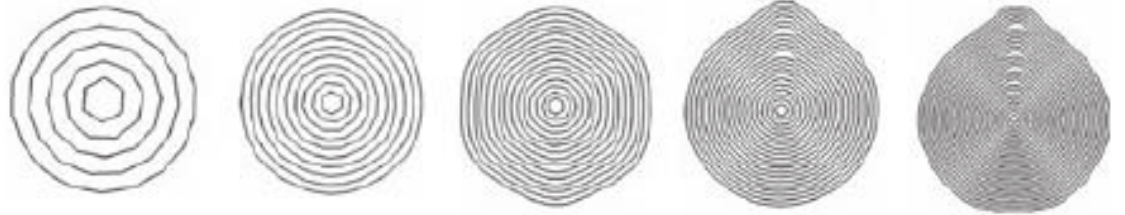
Figure 8. Cross-sectional views of relaxed MWNTs indexed by (2,8)/(4,16)/ . . . /(2 n ,8 n ). The wall numbers n are 5, 10, 15, 20, and 25 from left to right, and all the MWNTs are 20 nm long. Reprinted from Reference